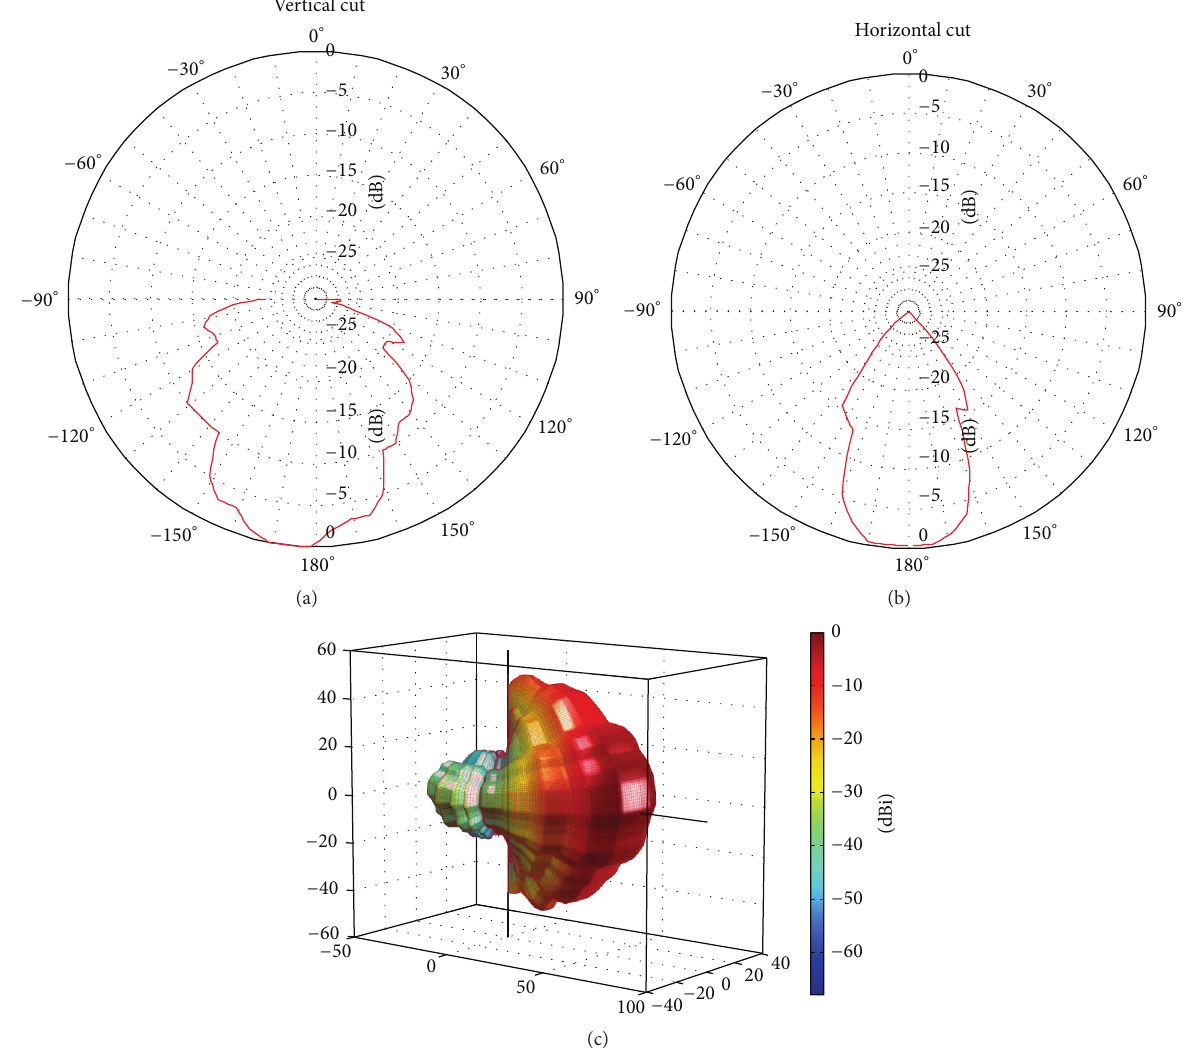
Figure 5: 3D pattern of the OBH08180 antenna, interpolated by the vertical and horizontal cut.